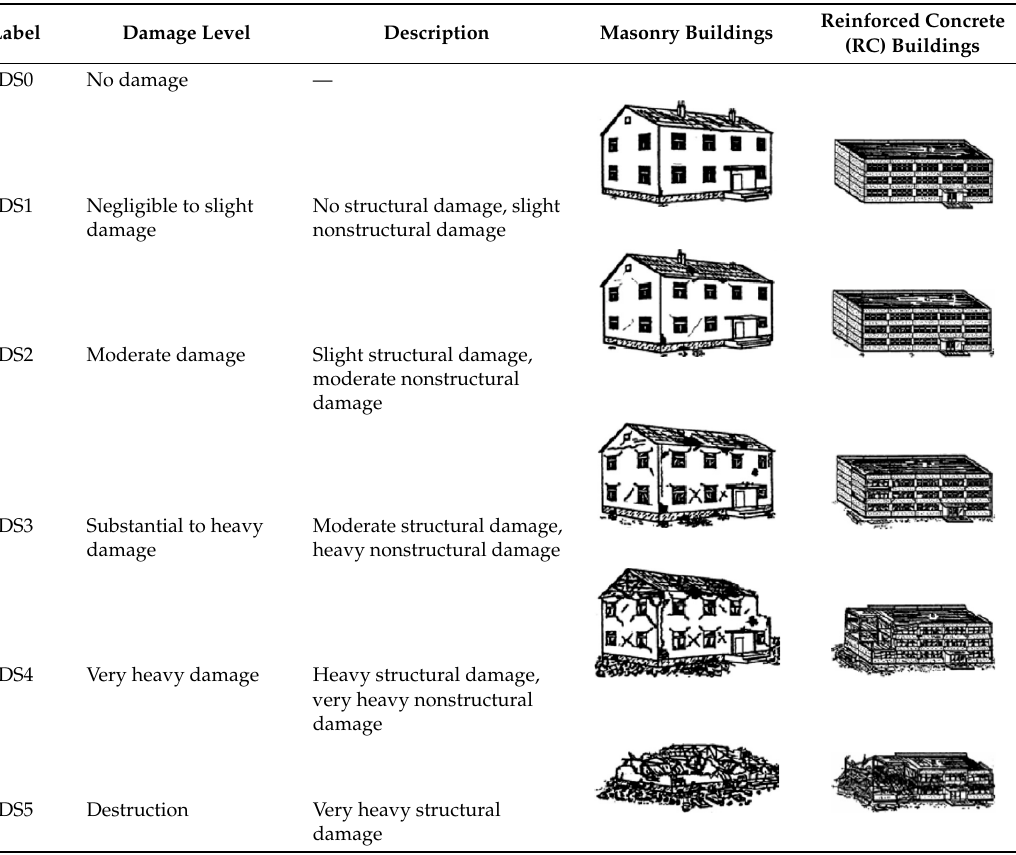
Figure 1. Collapse of a double ‐ layered masonry wall [1].